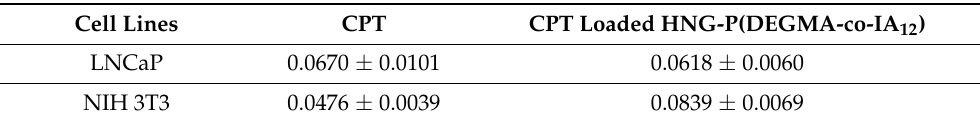
Table 5. IC 50 values of CPT and different CPT loaded HNG-P(DEGMA-co-IA 12 ) obtained over LnCaP and NIH 3T3 cell